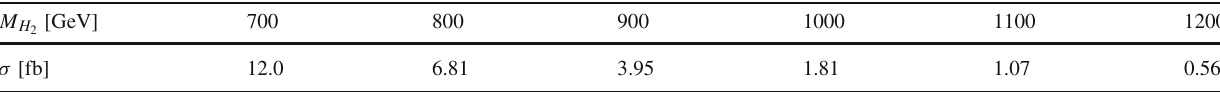
Table 3 Possible cross sections σ at 13 TeV for ggF → H 2 → h +